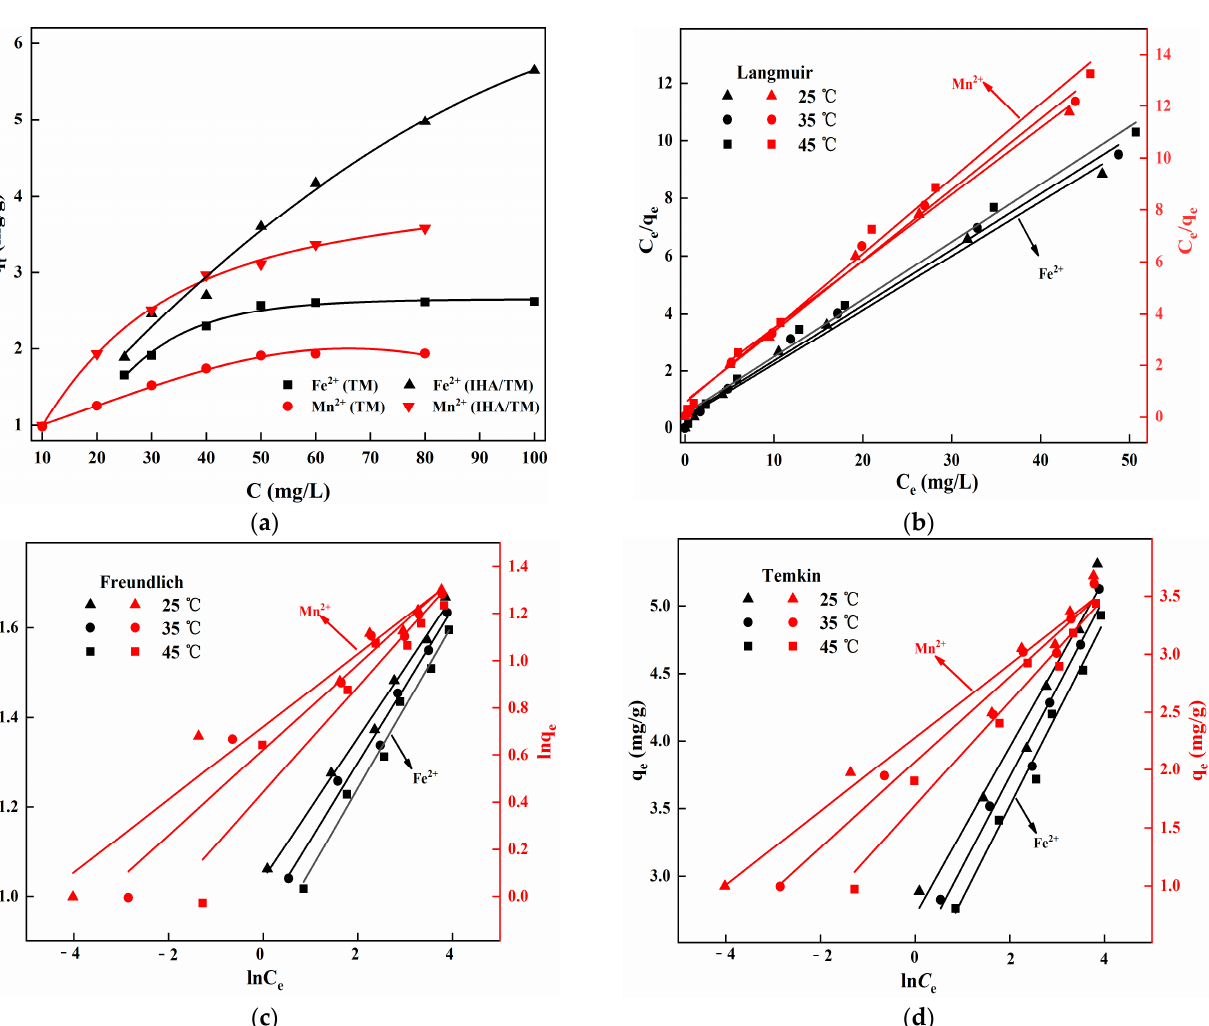
Figure 3. Effect of pH on the removal efficiency.